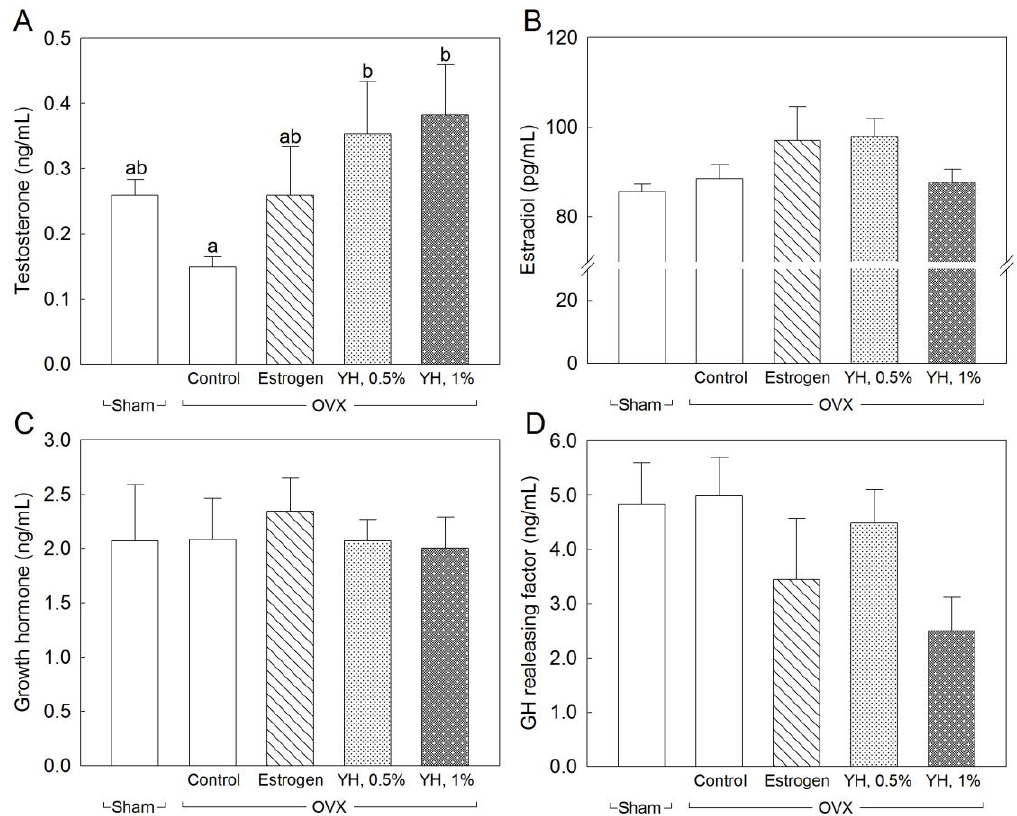
Figure 2. Serum hormone levels of ovariectomized (OVX) rats treated with yeast hydrolysate (YH) for 8 weeks. The data are presented as mean ± SEM for seven rats. According to Tukey’s multiple range tests, means with different superscript letters are significantly different ( p < 0.05). ( A ): testos- terone; ( B ): estradiol; ( C ): growth hormone; ( D ): growth hormone releasing factor. Sham: sham op- eration; Control: no treatment after OVX; Estrogen: estrogen treatment after OVX; YH, 0.5%: drink-